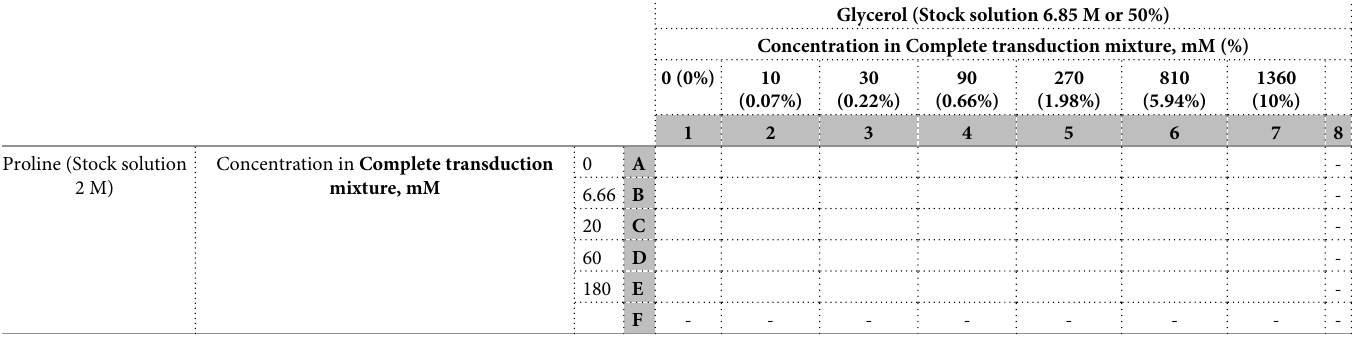
Row “F” and column #8 will be filled with